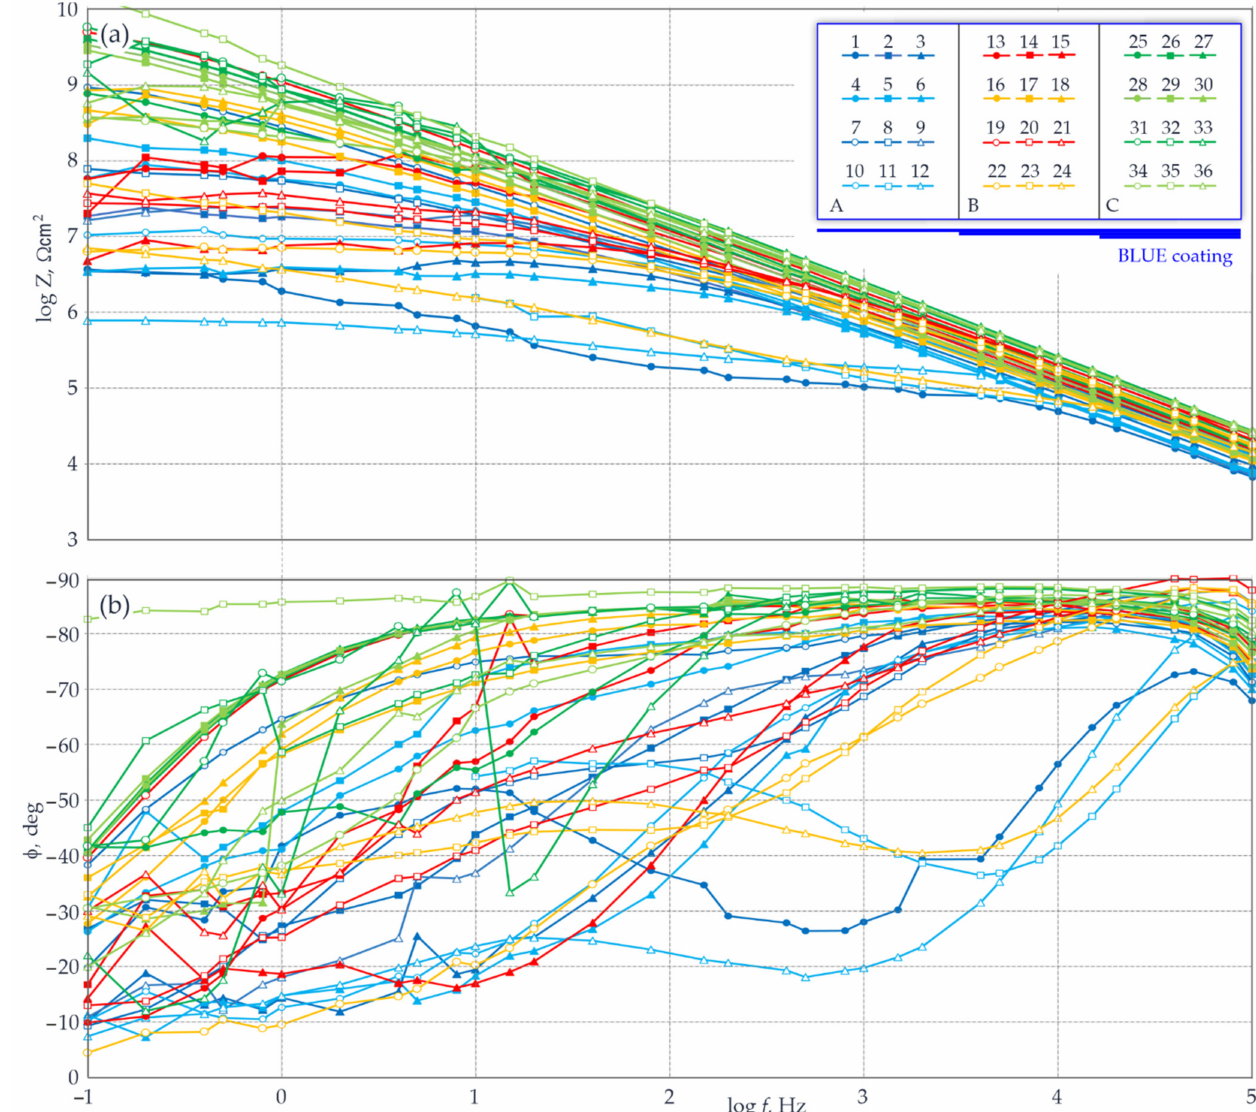
Figure 11. Measured impedance for the large steel sheet with the blue paint coating and the areas A, B, and C of different thickness of the coating: ( a ) the Bode plot Z(f); ( b ) the Bode plot ϕ (f)—described in the